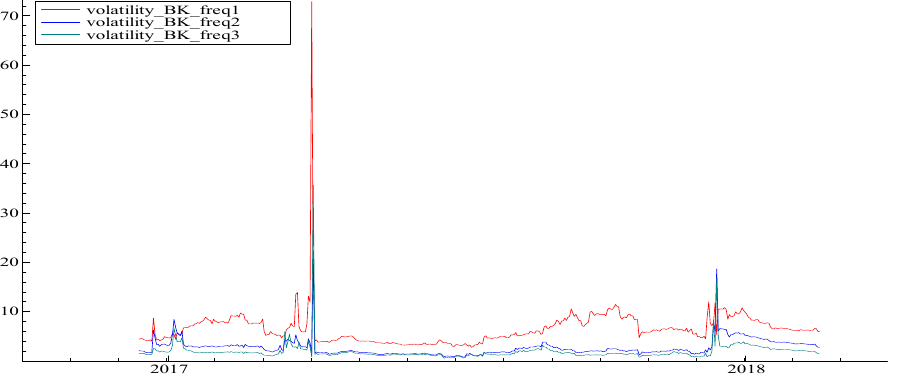
Figure 2. Time frequency-dynamic of cryptocurrency spill over indexes: window = 100 days and n. ahead = 100 days.